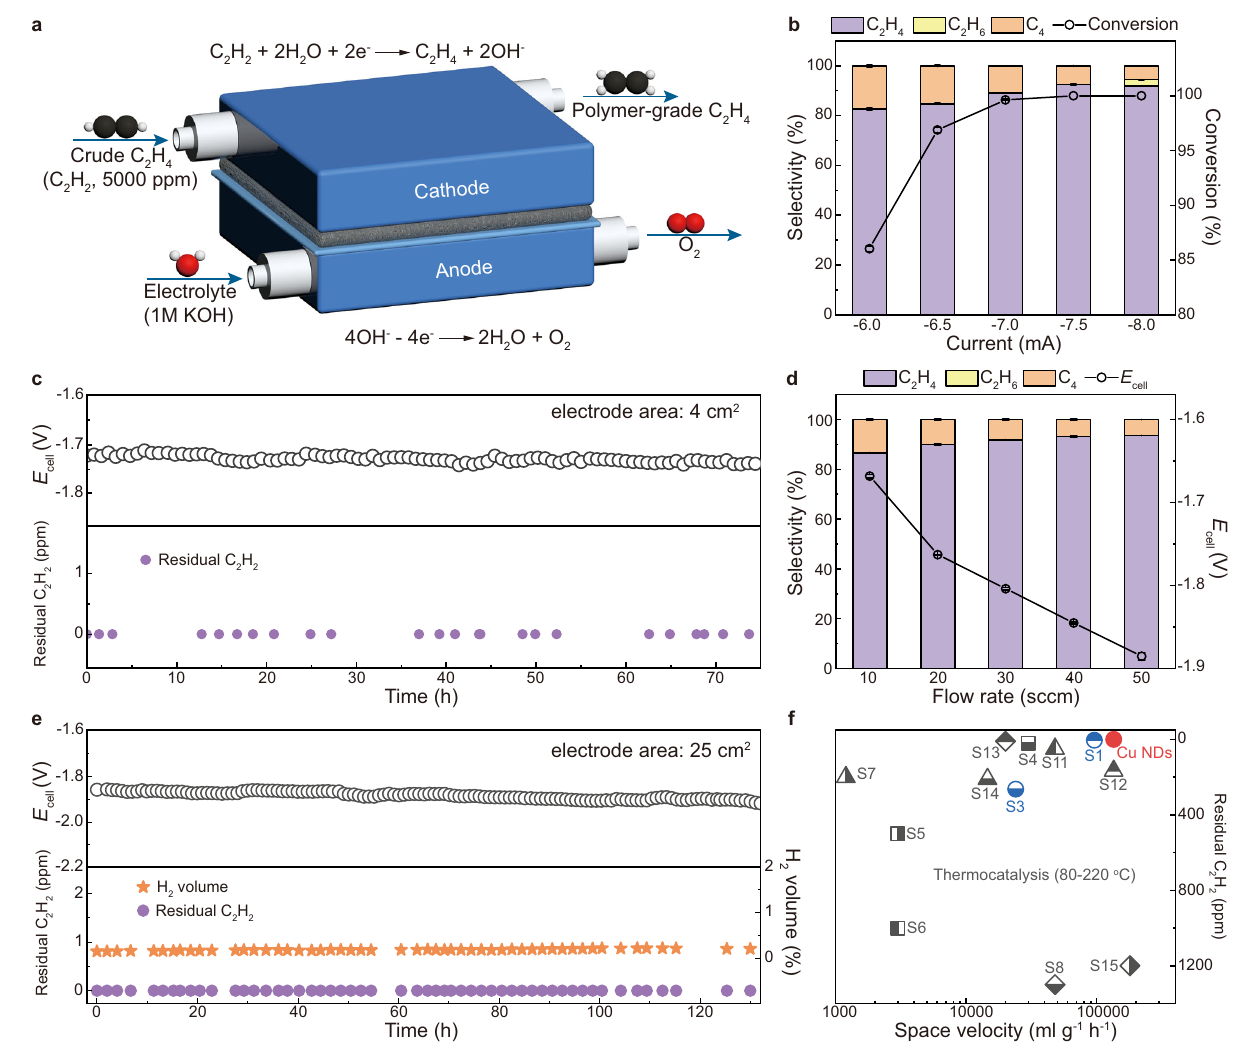
Fig. 4 | Acetylene removal in ethylene-rich simulated gas (0.5%C 2 H 2 , 20% C 2 H 4 balancedwithAr).a SchematicofthehomemadeMEA-typetwo-electrodereactor. Between the cathode and anode were the GDL loaded with catalyst and anion exchange membrane (AEM). b Selectivity of EASH products at different currents and corresponding C 2 H 2 conversion over Cu NDs in the two-electrode reactor (electrodearea,4cm 2 )ata fl owrateof10sccm. c Long-termoperationofEASHata constant current of − 7.50mA under the reaction conditions of ( b ). d Selectivity of EASHproductsatdifferent fl